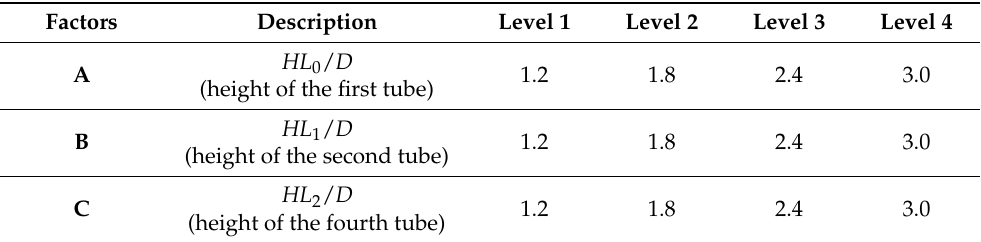
Table 2. The ranges and levels of the control parameters.